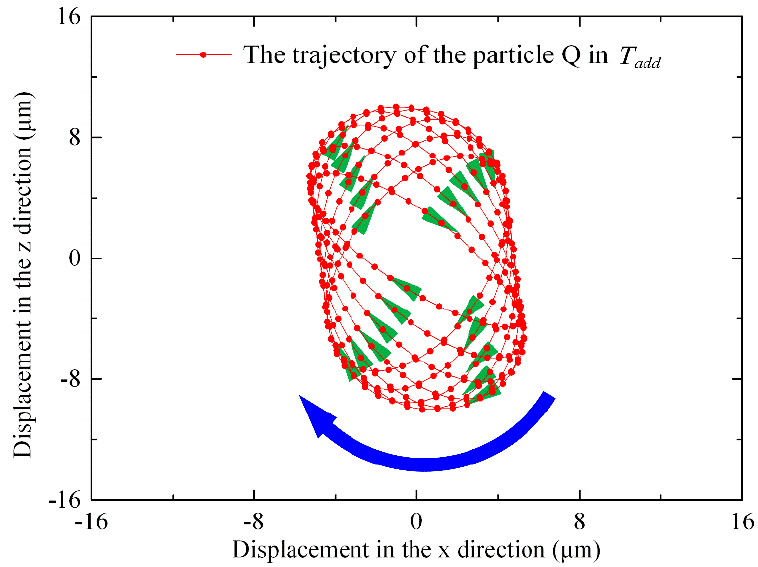
Figure 15. Elliptical trajectory of particle Q. Although the beat period of the vertical displacement is 4 π , as shown in Figure 16, ω q + ω n the beat vibration of the stator surface is not caused by the frequency difference but by the constant change in the amplitude of the stator’s two phases. When the stator surface is in T addT , as the stator surface propagates in the form of traveling waves, particle point Q does not change the rotation direction intermittently but keeps moving in a clockwise elliptical trajectory, which is consistent with the positive value of formula Q qadd ( t ) in Figure 17. Additionally, the change trend for the value of the determining factor of the elliptical motion Q qadd ( t ) and the tangential velocity v xmax ( t ) of the particle point H at the wave peak is also consistent in Figure 17.